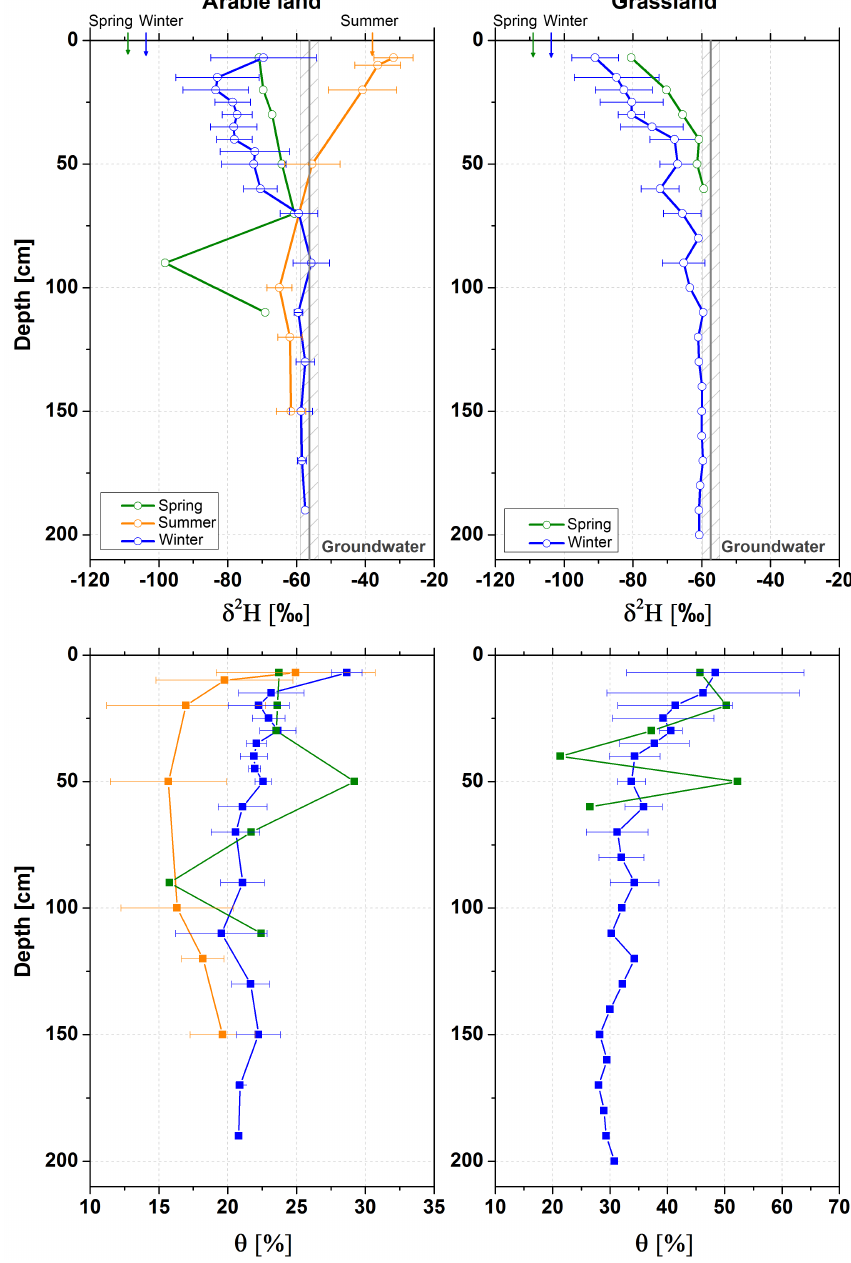
Figure 6. Seasonal δ 2 H profiles of soil water (upper panels) and water content (lower panels) for winter (28 March 2013), summer (28 Au- gust 2011), and spring (24 April 2013). Error bars represent the natural isotopic variation of the replicates taken during each sampling campaign. For reference, mean groundwater (grey shaded) and mean seasonal precipitation δ 2 H values are shown (coloured arrows at the